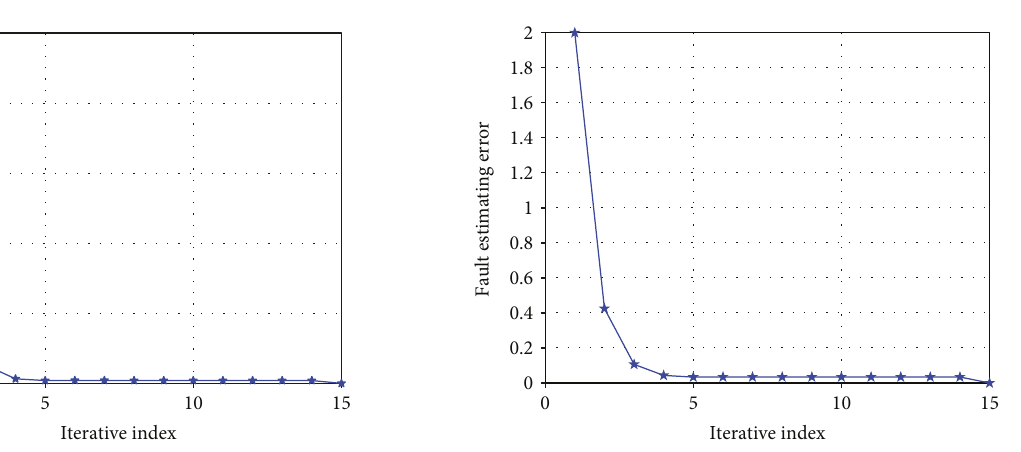
Figure 6: The tracking trajectory of intermittent fault for a nonlinear system with time-varying parameter uncertainties.